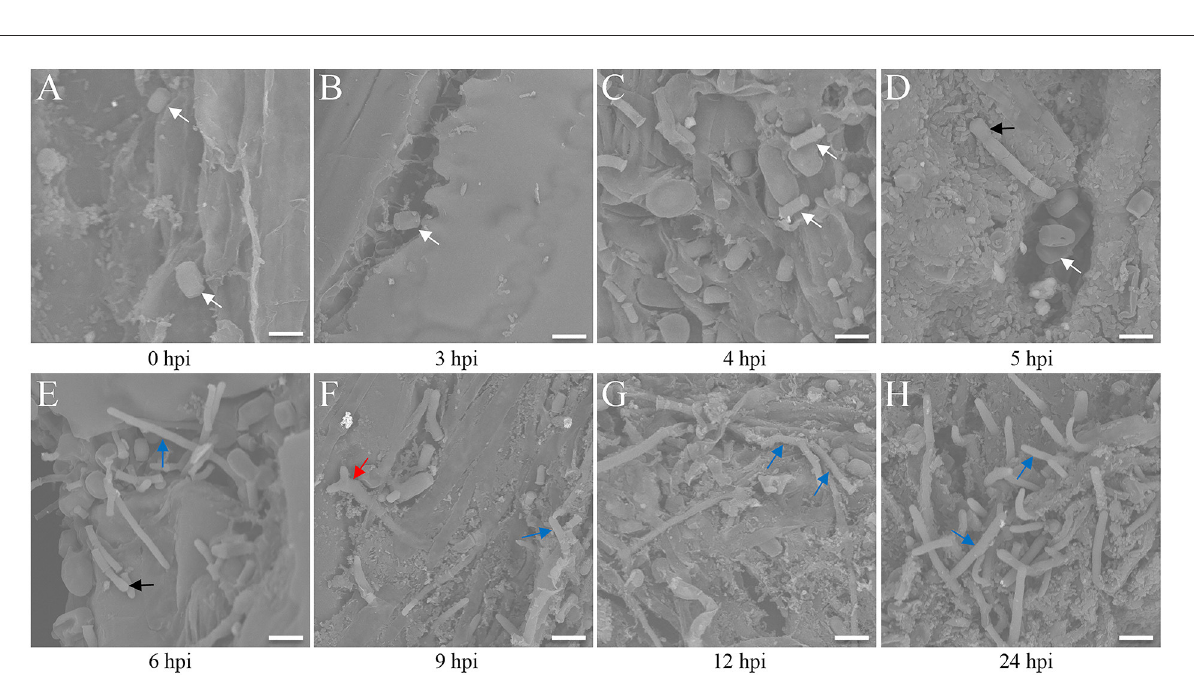
infection (3–6 hpi) (Figure 3A and Supplementary Table 2).